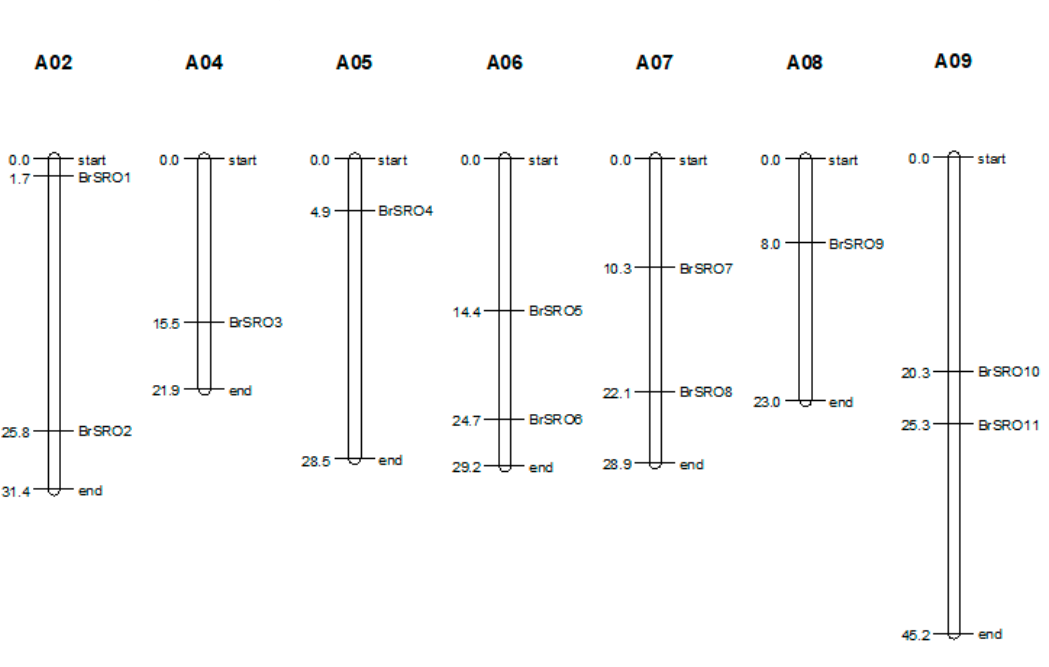
Table 1. Physiochemical characteristics of identified BrSRO genes.